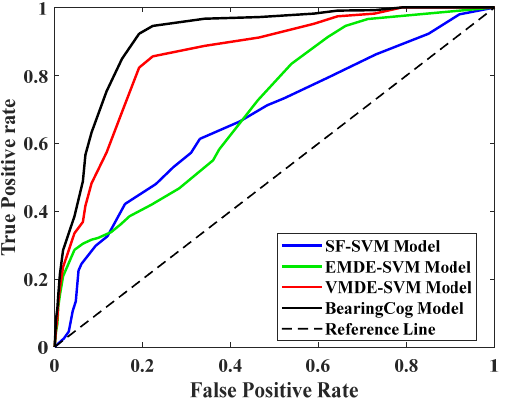
Figure 7. The ROC curve of four kinds of SVM classifiers.